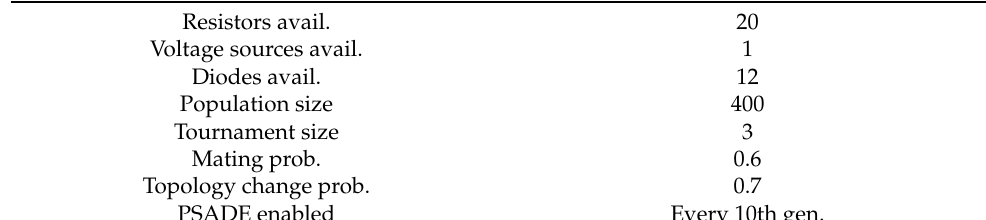
Table 2. The search parameters of the evolution of a failure-resilient square root analog circuit. Resistors avail. Voltage sources avail.